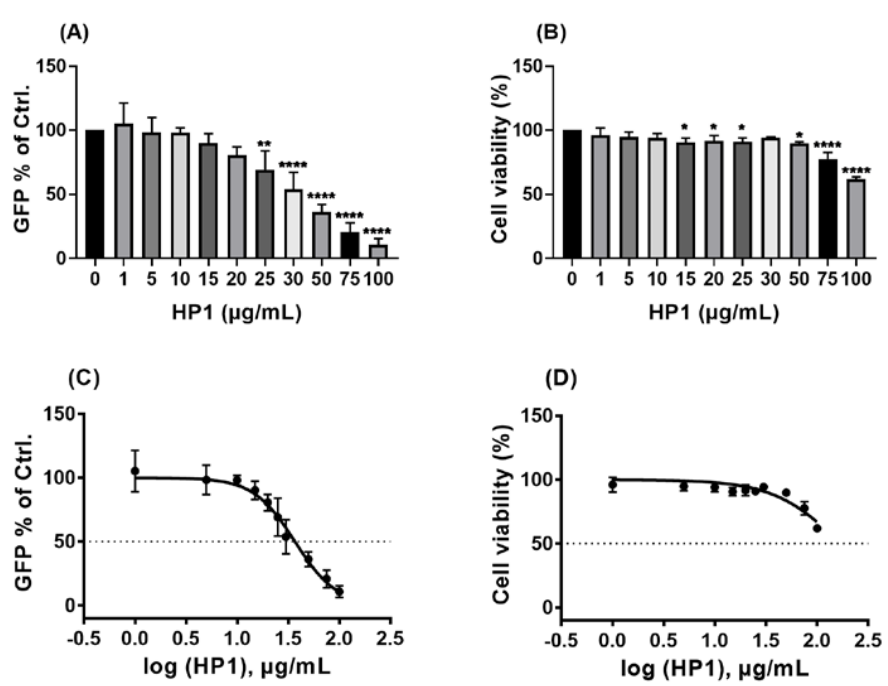
Figure 1. The antiviral activity of Hypericum perforatum (HP1) against the pseudo-typed VSV virus carrying the SARS-CoV-2 S protein. ( A , C ) Vero cells were seeded overnight, and on the next day, cells and the VSV-pseudo-typed virus were incubated with Hypericum perforatum (HP1) or solvent control (DMSO) for 1 h prior to infection, at 37 °C or room temperature, respectively. After pre- incubation, infection was performed with a MOI of 0.01 for 1 h, and cells were finally washed and incubated without further treatments. After 16–18 h, GFP signal was visualized under fluorescent microscope. ( A ) GFP-positive cells as % of control are shown (mean and s.d.), and one-way ANOVA with Dunnett’s multiple comparisons was done by comparing each value with the control. ( C ) Dose–response curve of the normalized GFP-positive cell values as % of control is depicted (mean and s.d.). ( B , D ) Vero cells were seeded overnight, and on the next day, incubation with HP1 or solvent control was initiated. 24 h after the start of incubation, the MTT assay-based cytotoxicity was measured. ( B ) Cell viability as % of control is shown (mean and s.d.), and one-way ANOVA with Dunnett’s multiple comparisons was done by comparing each value with the control. ( D ) Dose–response curve of the normalized cytotoxicity values as % of control is depicted (mean and s.d.). * for p ≤ 0.05, ** for p ≤ 0.01, and **** for p ≤ 0.0001